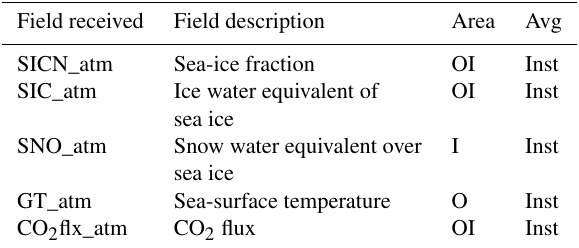
Table A1. Fields received by CanAM from CanCPL. The represen- tative area may be the full AGCM grid cell (land, ocean, and ice), “C”; open ocean, “O”, sea ice, “I”; or the combination. Fields may be instantaneous, “inst”, or averaged over the coupling cycle, “avg”.